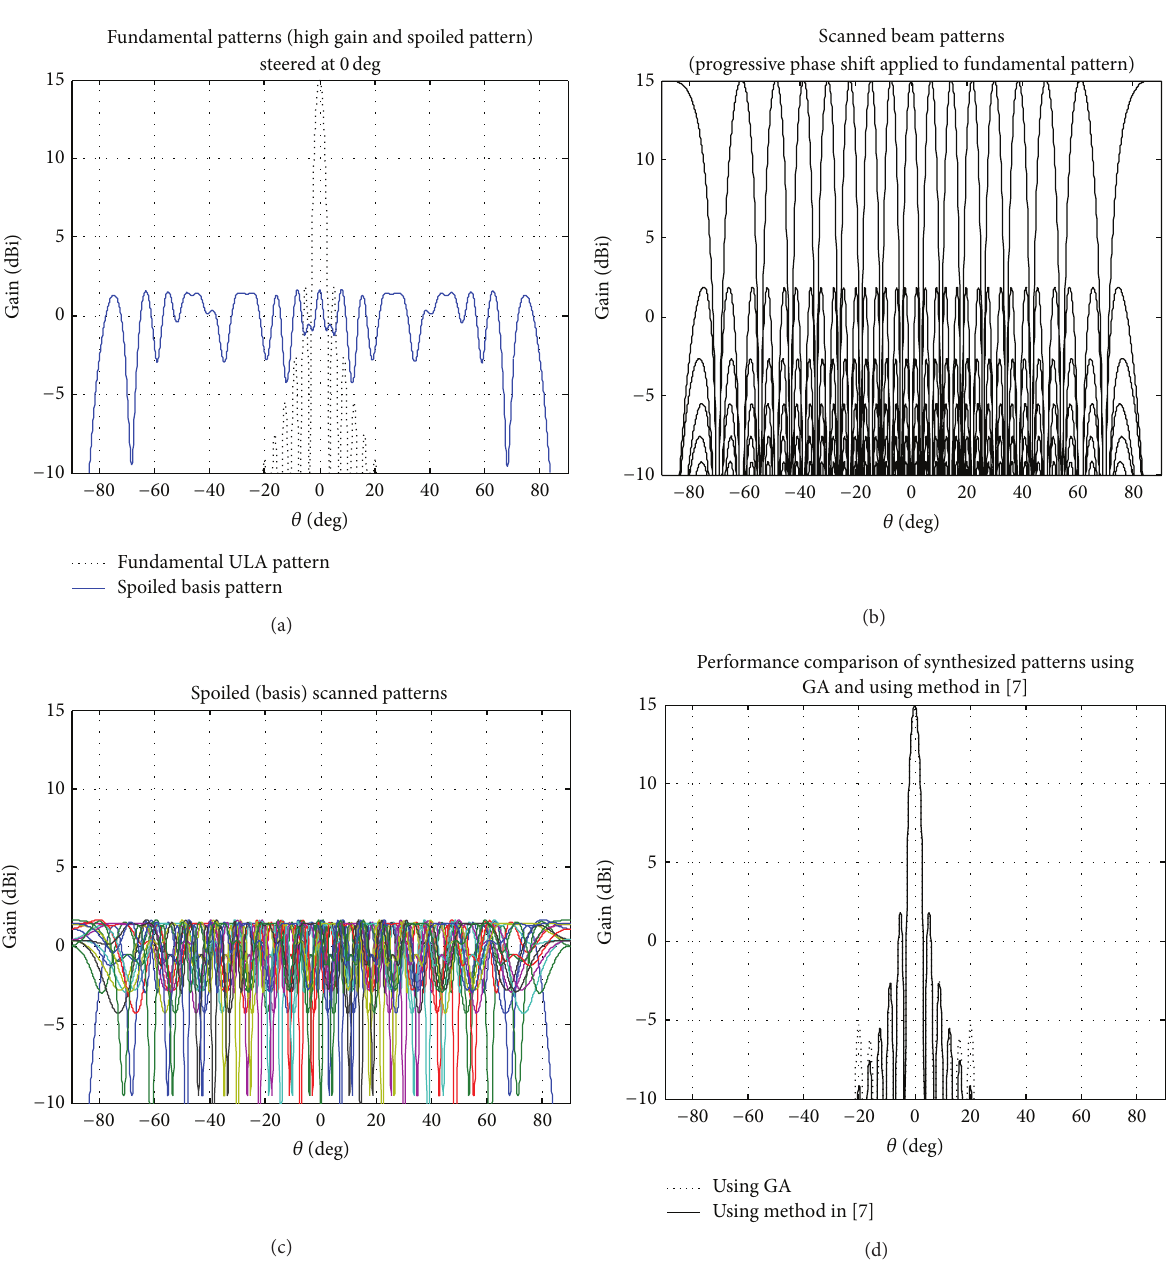
Figure 7: (a) Gain comparison between fundamental pattern and fundamental spoiled pattern; (b) scanned high gain beam patterns; (c) all spoiled beam patterns; (d) pattern synthesis performance of the GA and the author’s method in